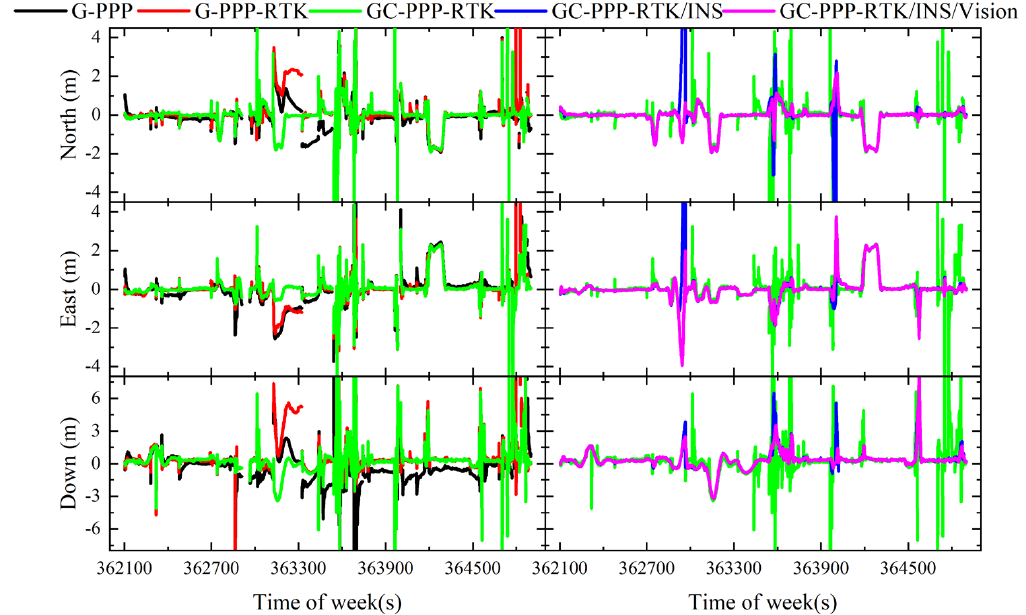
Figure 10. Position difference series of T02 in north, east, and down directions, respectively.